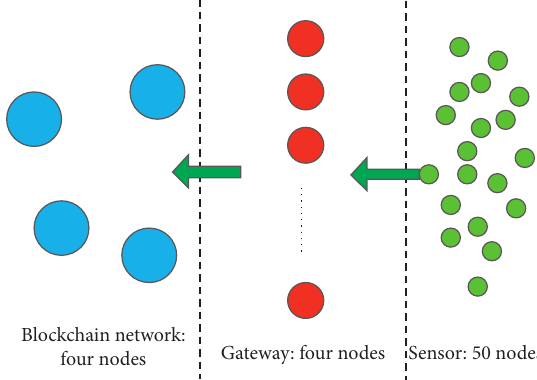
Figure 7: Transaction delay structure